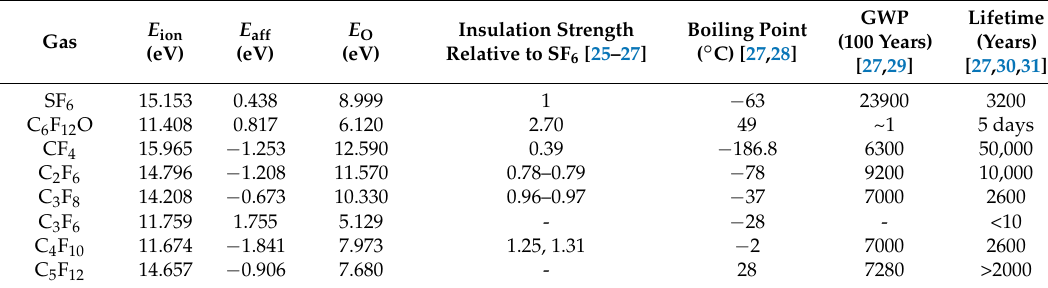
Table 3. Parameter comparison of C 6 F 12 O decomposition